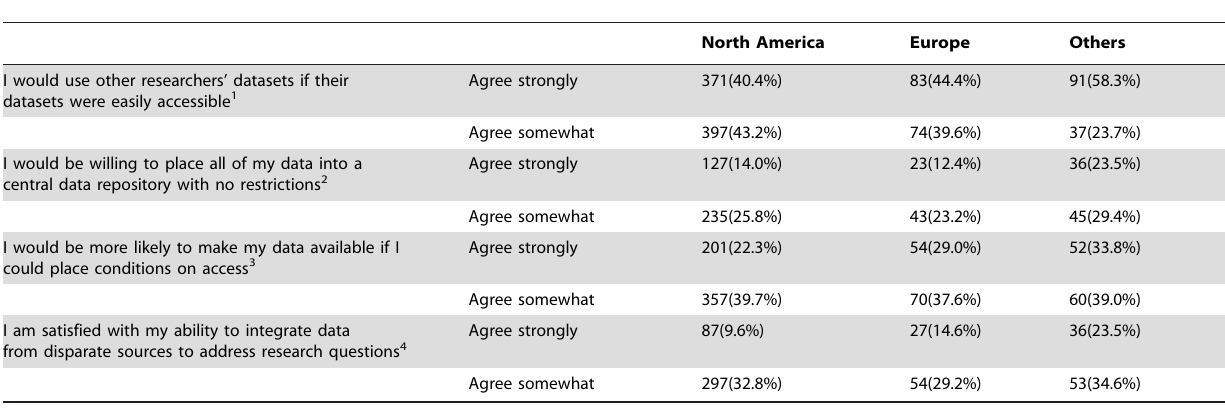
Table 35. Conditions for data sharing by geographic location.